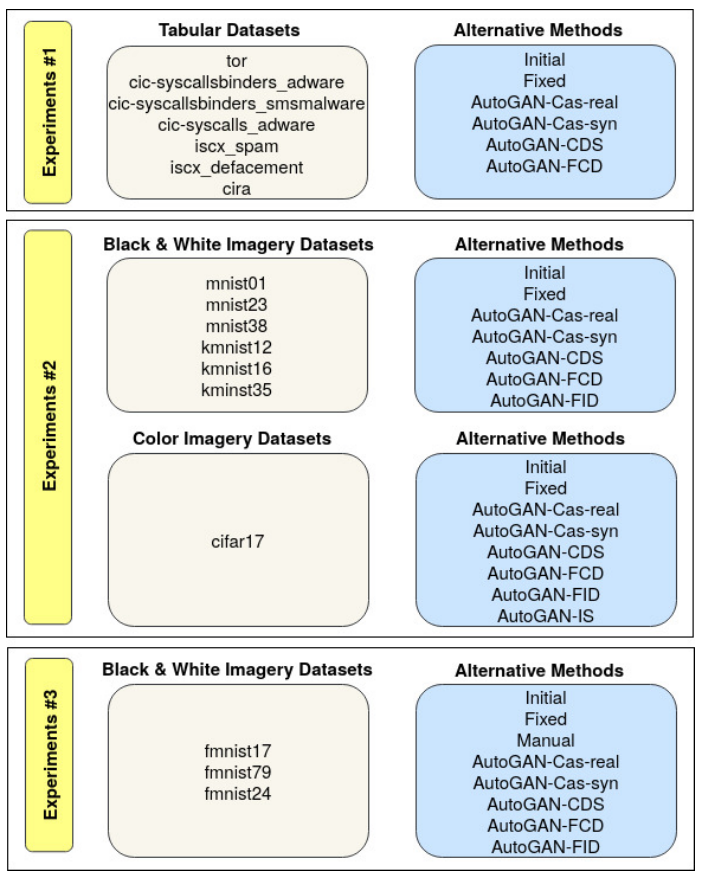
Figure 9. Detailed description of the three main experiments carried